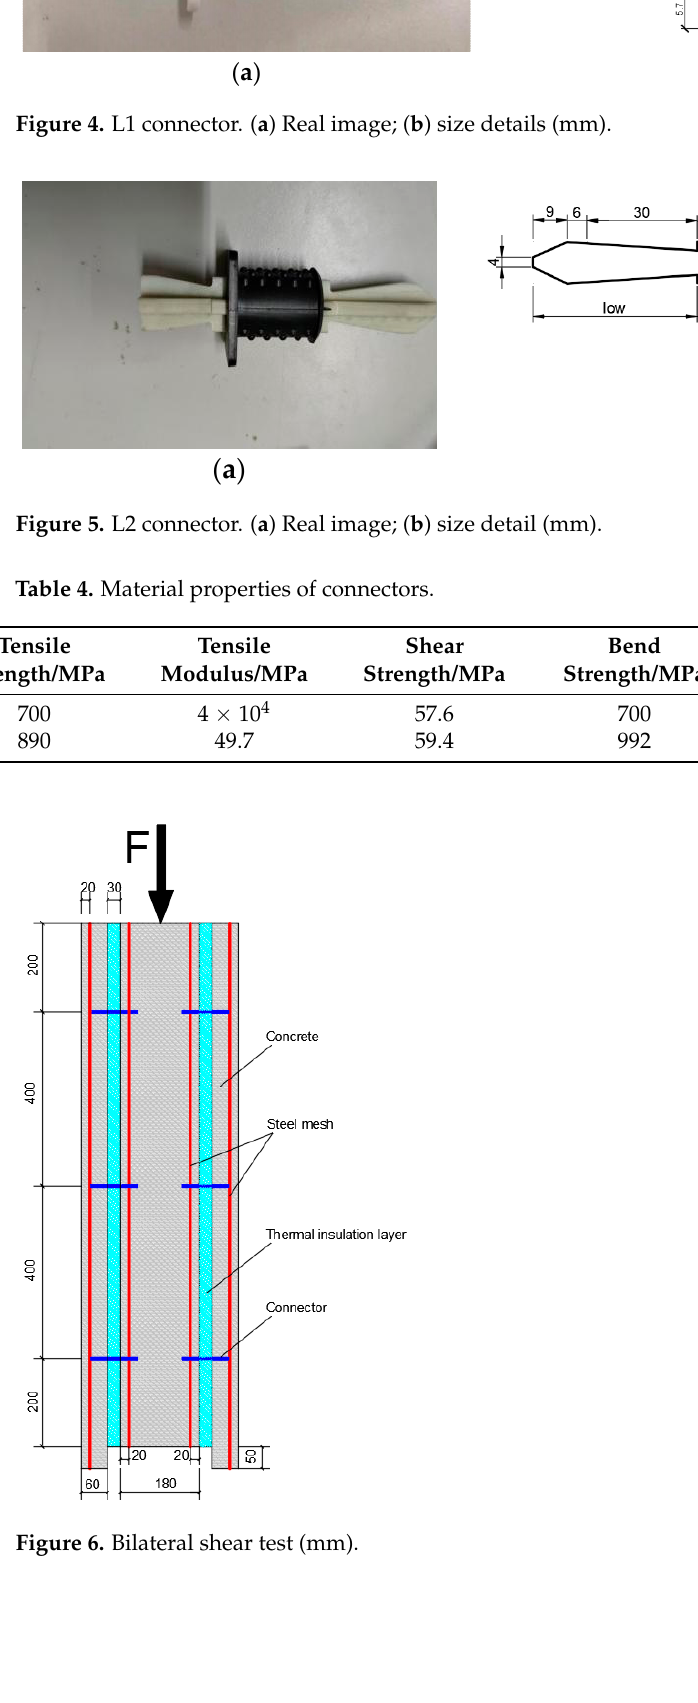
Figure 6. Bilateral shear test (mm).